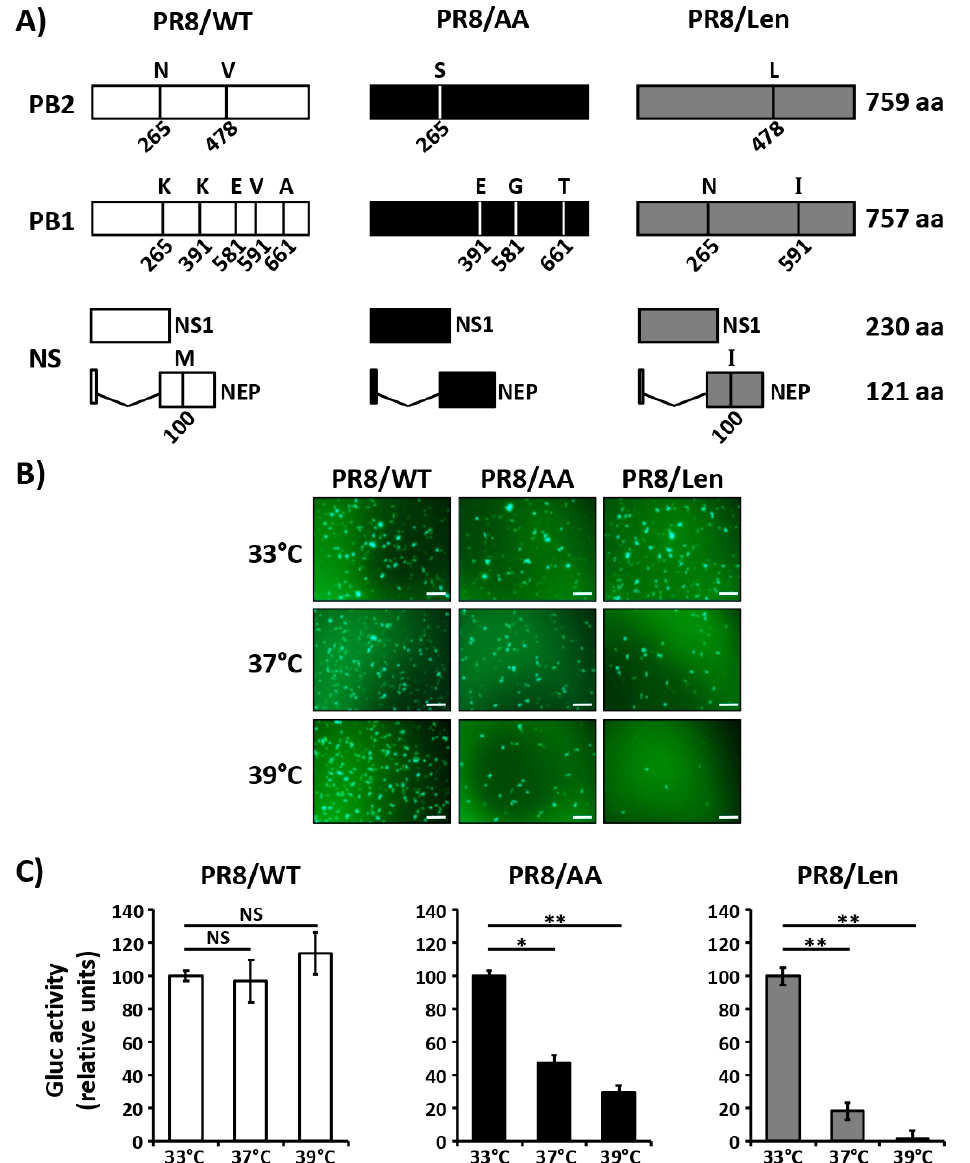
Figure 1. E ff ect of temperature on the polymerase activity of PR8 / AA and PR8 / Len. ( A ) Schematic Figure 1. Effect of temperature on the polymerase activity of PR8/AA and PR8/Len. ( A ) Schematic representation of segments 1 (PB2), 2 (PB1) and 8 (NS) of PR8 / WT (white, left), PR8 / AA (black, middle) representation of segments 1 (PB2), 2 (PB1) and 8 (NS) of PR8/WT (white, left), PR8/AA (black, and PR8 / Len (grey, right). Amino acid substitutions to generate PR8 / AA and PR8 / Len are indicated. middle) and PR8/Len (grey, right). Amino acid substitutions to generate PR8/AA and PR8/Len are B-C) Minigenome activity: HEK293T cells (12-well plate format, 4 × 10 5 cells / well, triplicates)